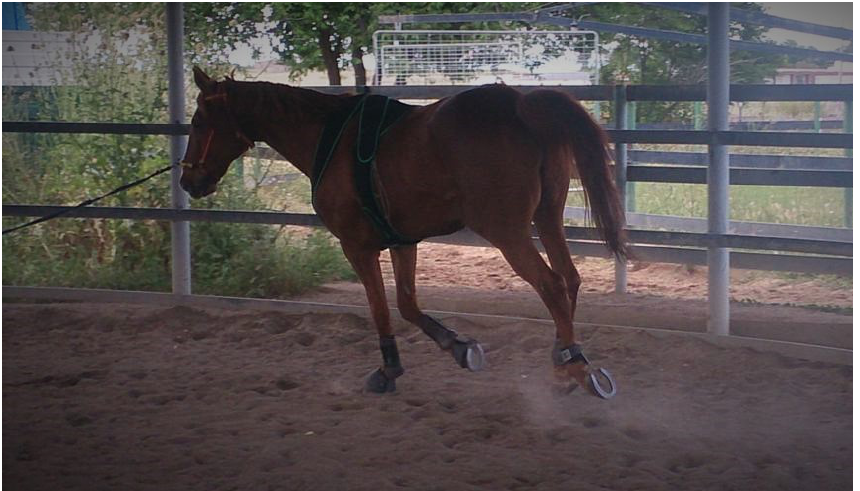
Figure 3. A horse during an exercise